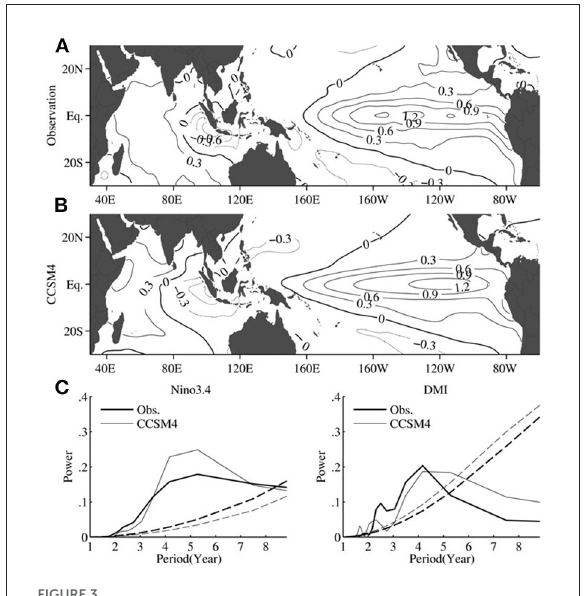
FIGURE3 Comparison of the observed [ (A) ; HadISST] and simulated (B) regression coefficients between the DMI index and the SSTA in the Indian Ocean and between the Niño3.4 index and the SSTA in the Pacific Ocean. The simulated regression coefficients are calculated based on the simulated DMI and Niño3.4 index. Bottom panels (C) show the power spectra of the observed and simulated Niño3.4 and DMI indices, respectively. Dash curves indicate 95% confidence level based on the red noise